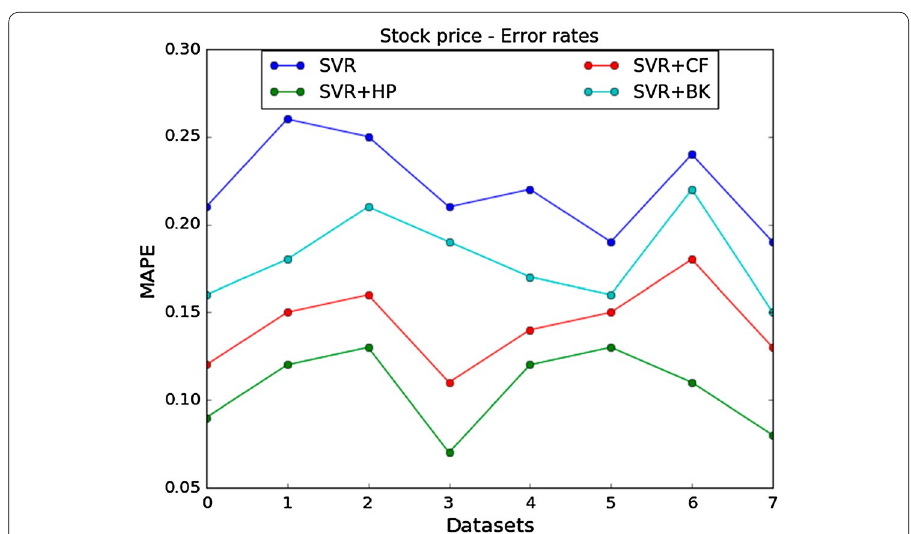
Fig. 10 MAPE (Error rate) of the predictive models